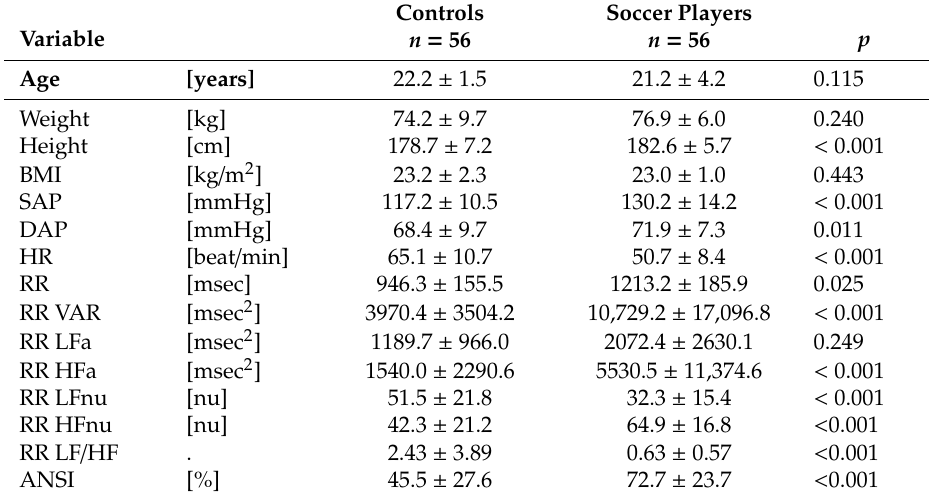
Table 2. Descriptive population values and cardiac autonomic indices in a group of Italian A series soccer players and a group of control